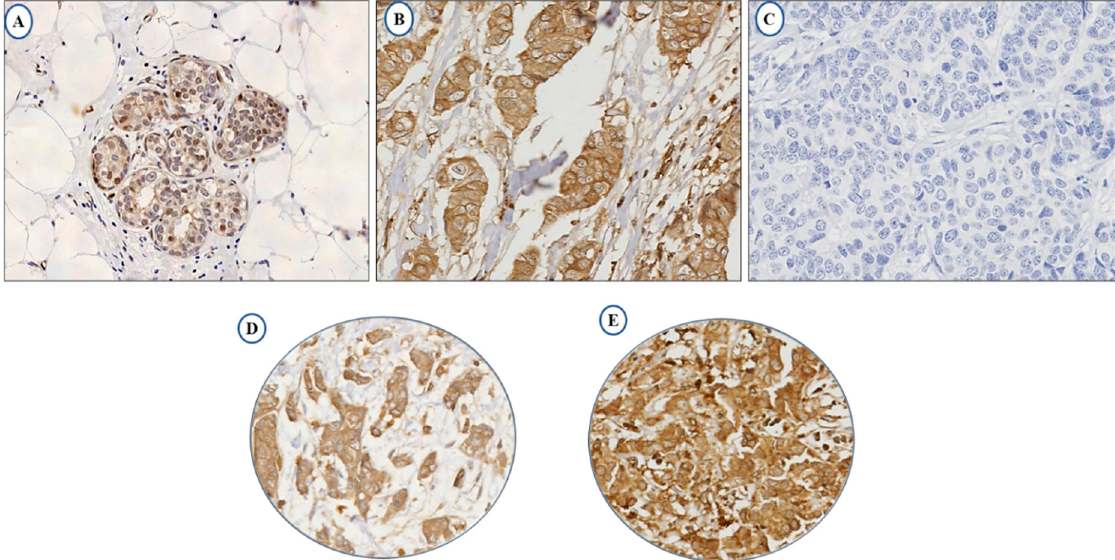
Figure 1. Photomicrographs showing immunohistochemical expression of LAIR-1 in breast cancer: morphological char- acteristics of LAIR-1 immunohistochemistry in full-face breast cancer tissue ( A – C ). Normal terminal ductal lobular unit showing weak LAIR-1 expression ( A ) and ( B ) showing slightly increased immunoreactivity in invasive tumour cells. ( C ) showing the negative control that was performed omitting the primary antibody. LAIR-1 protein expression in breast cancer tissue microarray (TMA) cores showing low ( D ) and high ( E ) immunoreactivity respectively